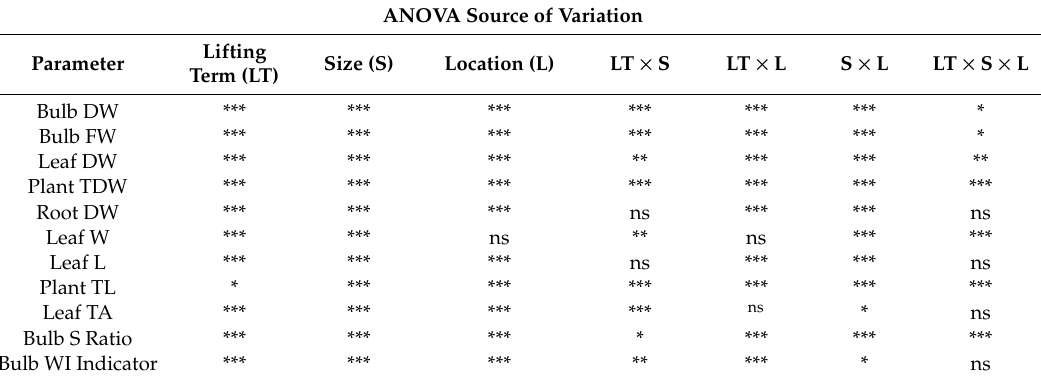
Table 2. Results of ANOVA for the analyzed parameters a ff ected by lifting time, bulb size, localization and